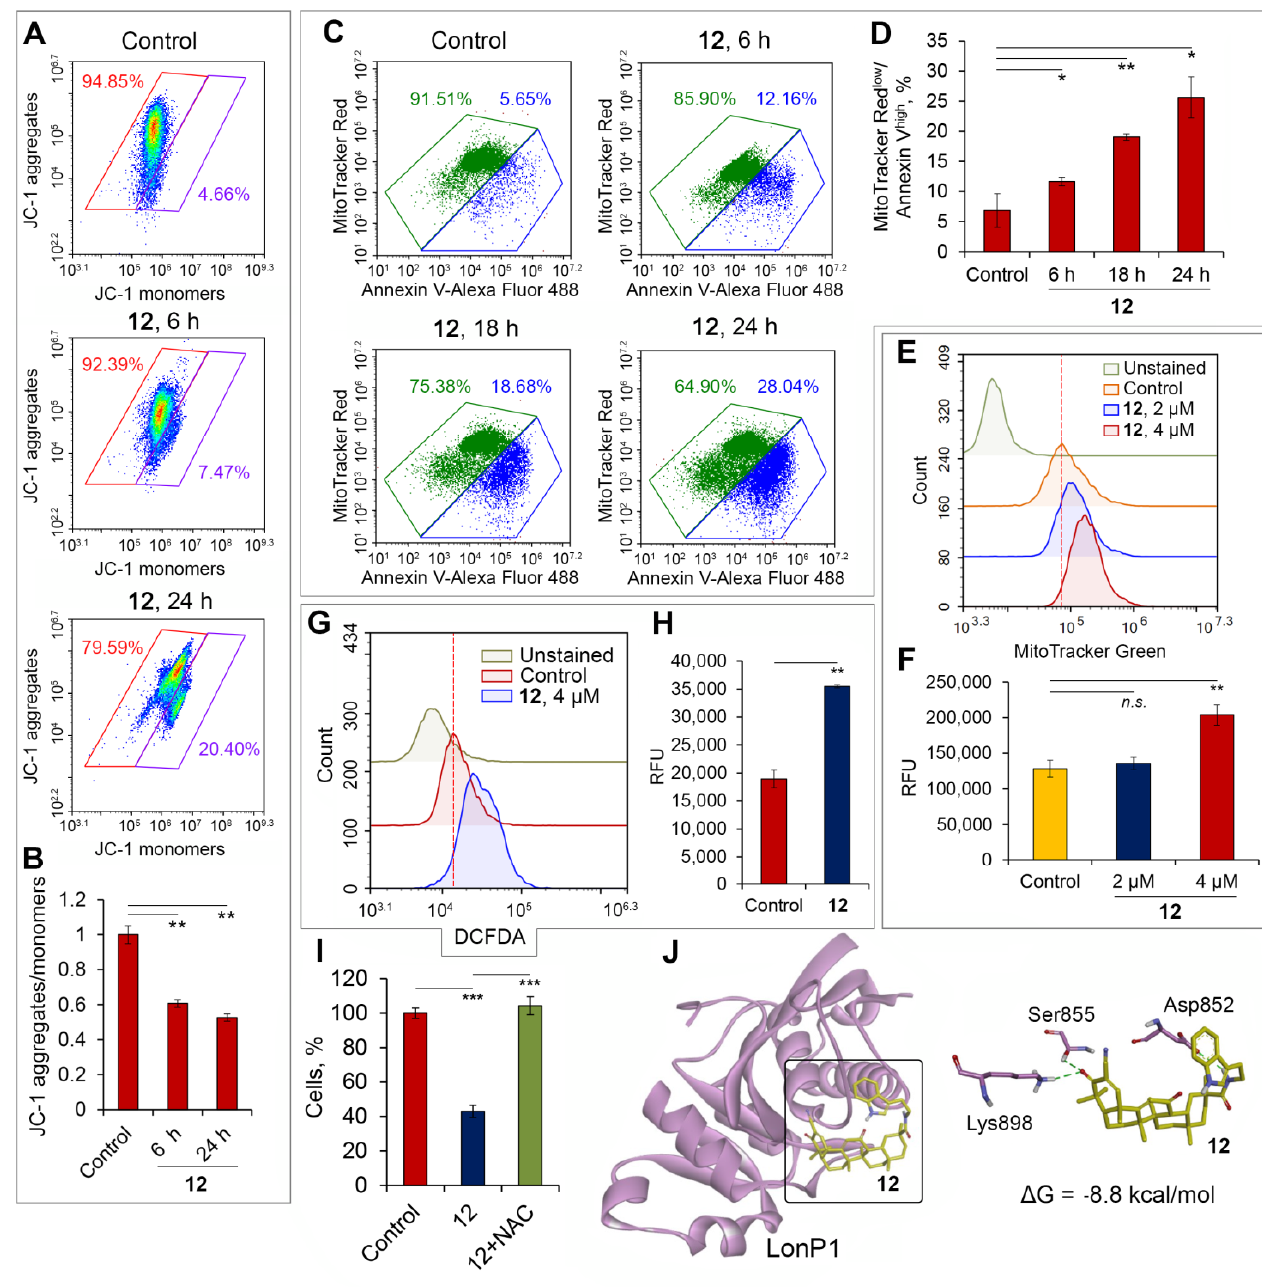
Figure 6. The effect of 12 on mitochondrial homeostasis in glioblastoma cells. ( A ) Time-dependent effect of 12 on ∆ ψ M in U118 cells. Representative density plots of flow cytometry analysis of U118 cells treated with 12 (4 µ M) and stained with JC-1. ( B ) The histogram shows the ratio of JC-1 aggregates to monomers for the control and experimental groups. The data are expressed as means ± SD of two independent experiments with at least 10,000 events per sample. ( C ) Time-dependent effect of 12 on ∆ ψ M in U87 cells. Representative density plots of flow cytometry analysis of U87 cells treated with 12 (4 µ M) and stained with MitoTracker Red and Annexin V-Alexa Fluor 488. ( D ) The histogram shows the percentage of apoptotic cells with low ∆ ψ M in control and experimental samples. The data are expressed as means ± SD of two independent experiments with at least 10,000 events per sample. ( E ) Representative histogram plot overlay of MitoTracker Green fluorescence intensity in U87 cells exposed to 12 for 24 h. ( F ) The histogram shows the relative fluorescence intensity of the cells incubated with or without 12 and stained with MitoTracker Green. The data are expressed as means ± SD of three independent experiments with at least 10,000